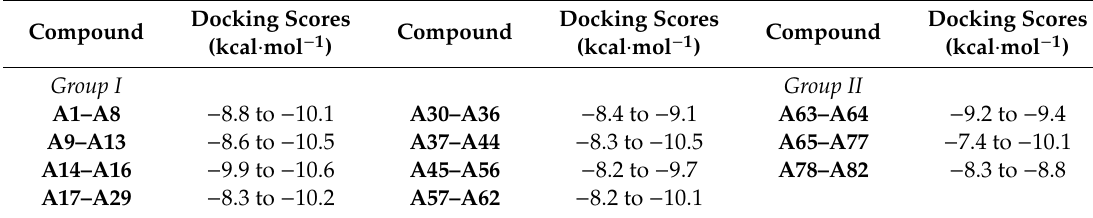
Table 2. Docking scores of aurone derivatives in Group I and Group II.